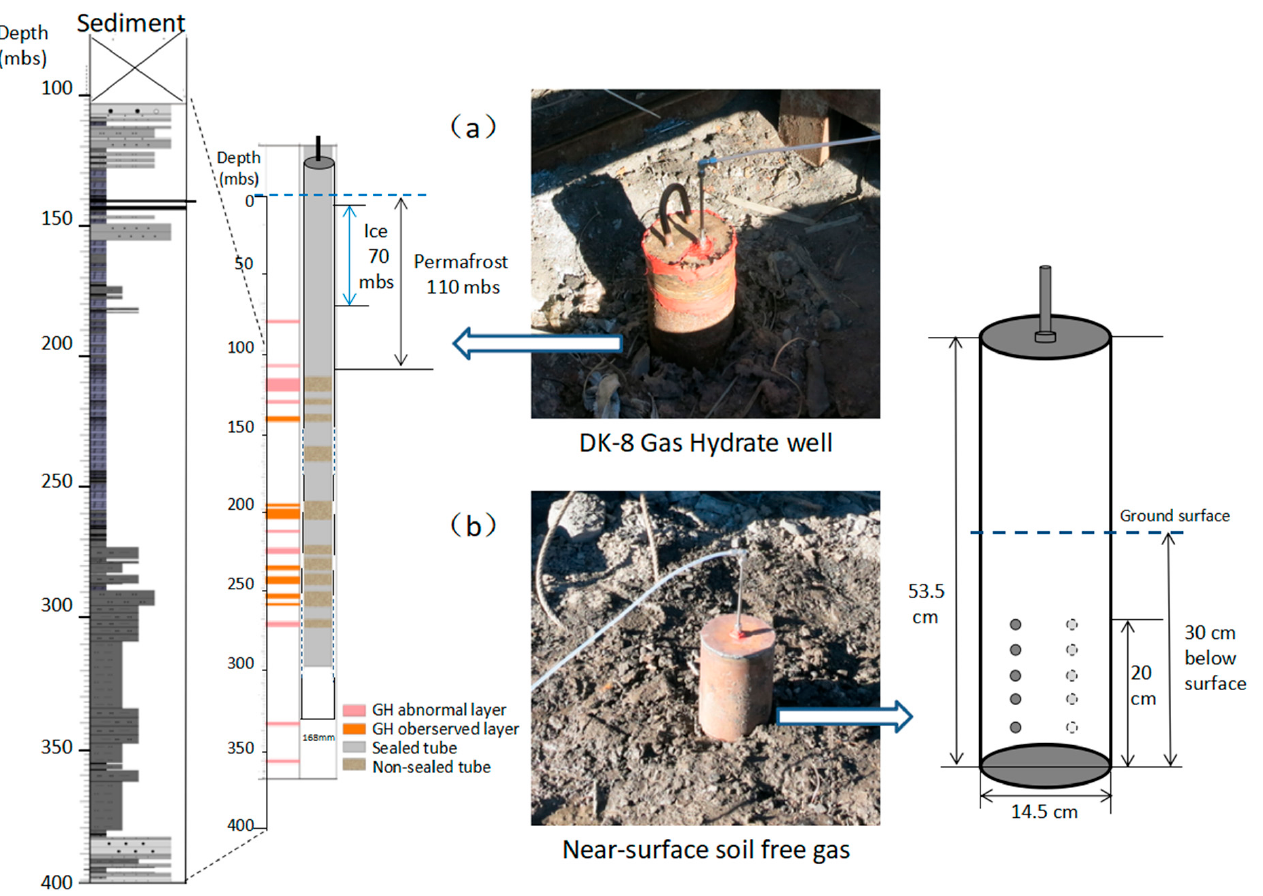
Figure 2. Field monitoring method, ( a ) gas hydrate drilling well DK-8, ( b ) near-surface soil-free gas monitored by the designed cylindrical soil respiration chamber.